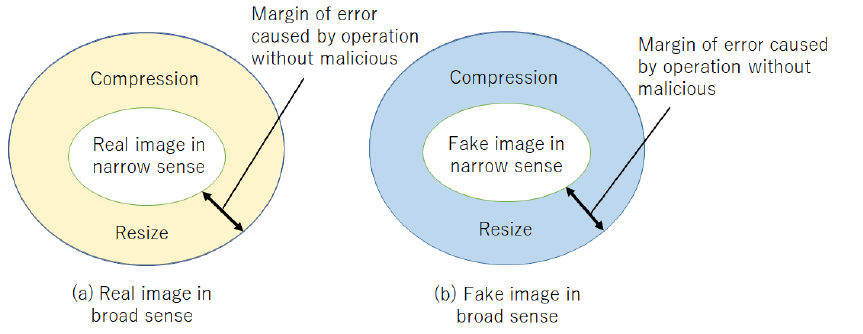
Figure 1. Real and fake images. ( a ) Real image in broad sense; ( b ) Fake image in broad